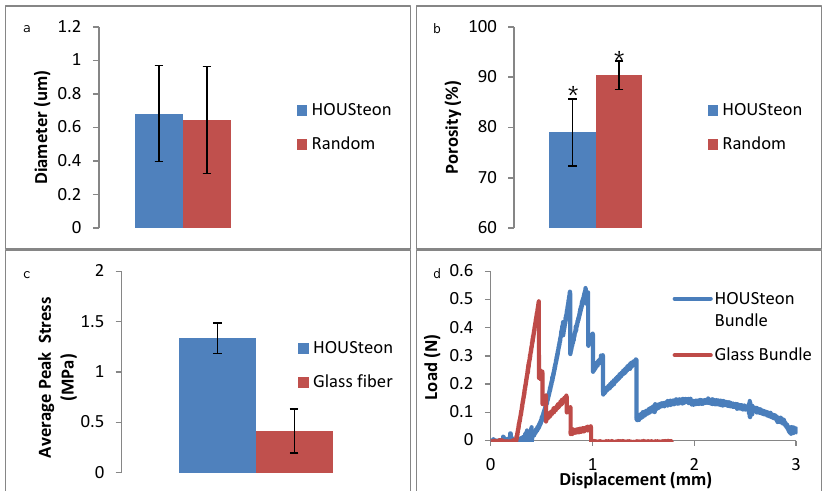
Figure 6. Physical characterization of ( a ) average PCL fiber diameter and ( b ) porosity between the HOUSTeon and randomly aligned PCL. The 3-point bending of ( c ) the peak stress between the HOUSteon and bare glass at 0.01 mm/s. ( d ) A representative 3-point bending load-displacement curve comparing a bundle of eight HOUSteons and 8 bare glass. * denotes significant di ff erence ( p < 0.05).